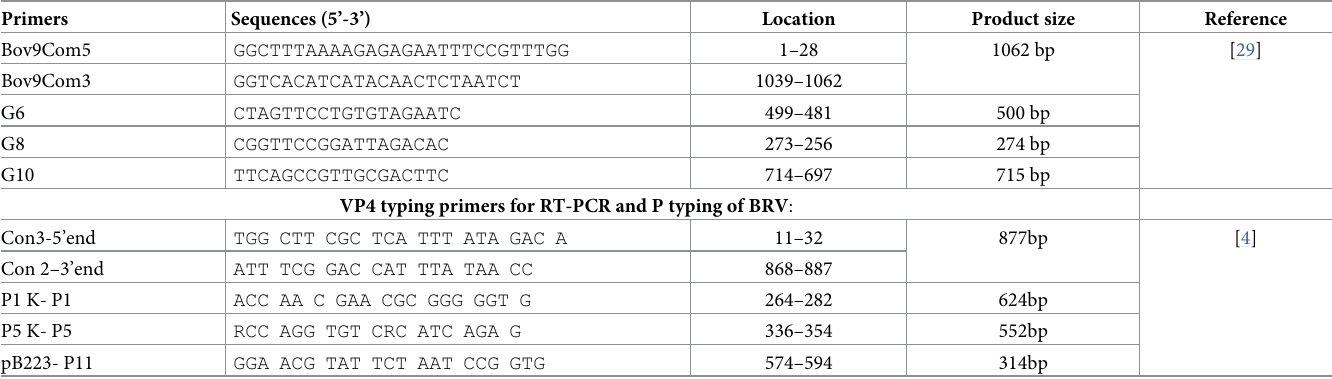
Table 1. Oligonucleotide primers used in RT-PCR assay and sequencing of the PCR